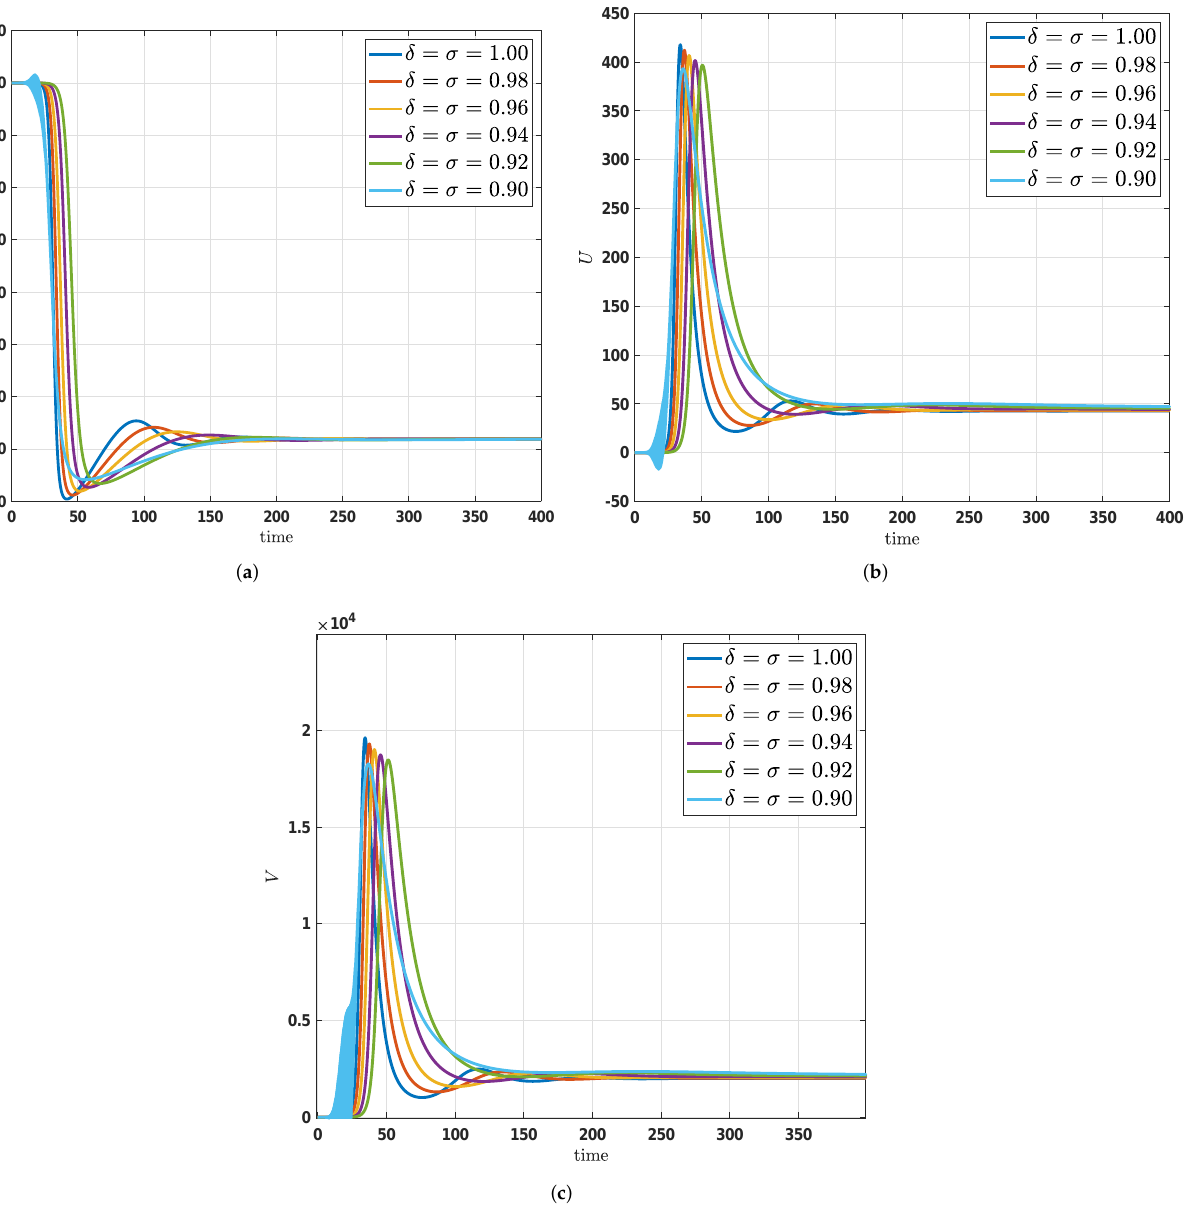
Figure 3. Numerical trajectories by varying both fractal order and fractional order δ = σ = 1.00, 0.98, 0.96, 0.94, 0.92, 0.90 via the Newton polynomials method. ( a ) Amount of susceptible CD4 + T-cells. ( b ) Amount of infectious CD4 + T-cells. ( c ) Free particles of the infection of the HIV-1 virus in the